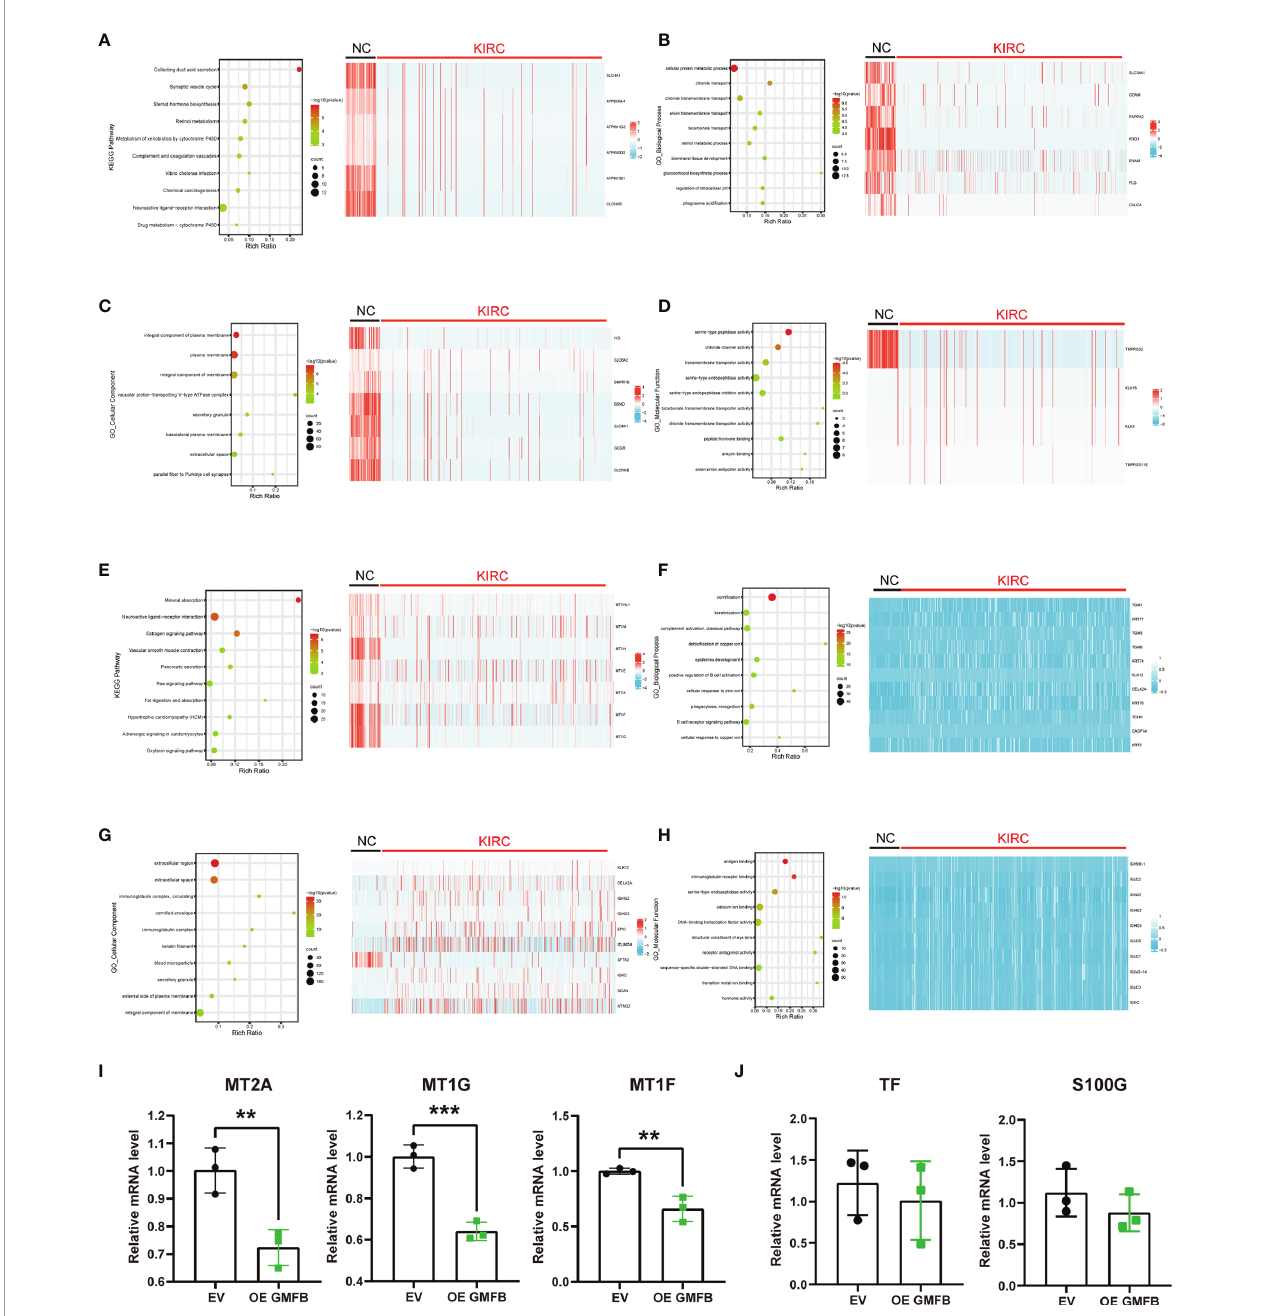
FIGURE 6 | Differentially expressed genes with Gmfb in signi fi cant Kyoto Encyclopedia of Genes and Genomes (KEGG) pathway and Gene Ontology (GO) term analyses in kidney renal clear cell carcinoma (KIRC). (A) Signi fi cant KEGG pathways of 958 upregulated differentially expressed genes (DEGs) and the heatmap of genes in the fi rst pathway collecting duct acid secretion. (B) Enriched GO-BP terms in 958 upregulated DEGs and the heatmap of genes in the fi rst term cellular protein metabolic process. (C) Enriched GO-CC terms in 958 upregulated DEGs and the heatmap of genes in the fi rst term integral component of the plasma membrane. (D) Enriched GO-MF terms in 958 upregulated DEGs and the heatmap of genes in the fi rst term serine-type peptidase activity of (G, E) Signi fi cant KEGG pathways of 2,581 downregulated DEGs and the heatmap of genes in the fi rst pathway mineral absorption. (F) Enriched GO-BP terms in 2,581 downregulated DEGs and the heatmap of genes in the fi rst term corni fi cation. (G) Enriched GO-CC terms in 2581 downregulated DEGs and the heatmap of genes in the fi rst term extracellular region. (H) Enriched GO-MF terms in 2,581 downregulated DEGs and the heatmap of genes in the fi rst term antigen binding. (I, J) The downregulated DEGs of mineral absorption were determined by RT-qPCR. (I) MT2A, MT1G, and MT1F had a signi fi cant difference. (J) TF and S100G had no signi fi cant difference. Error bars represent SD. **p < 0.01, ***p <